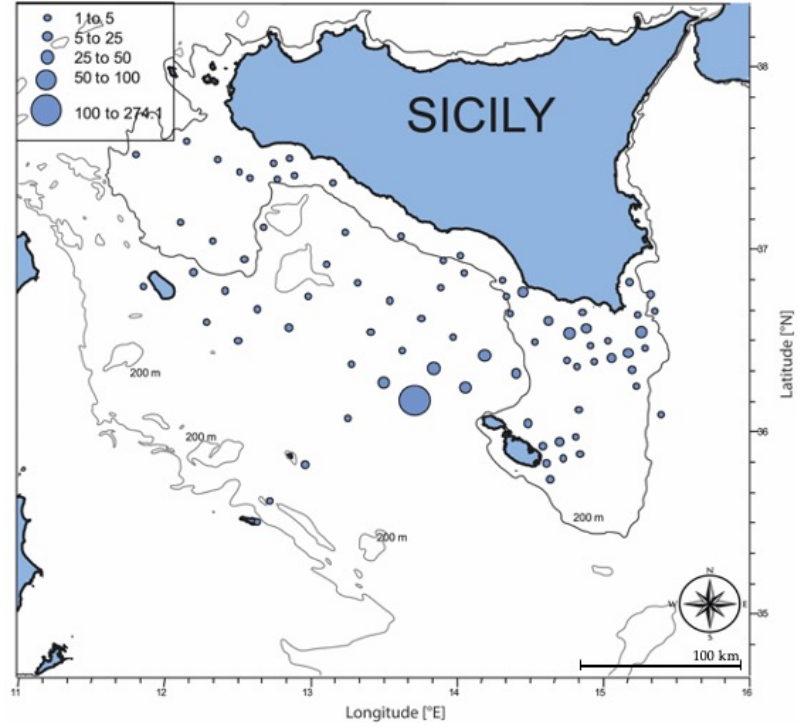
Figure 3. Abundance of anchovy larvae in the sampling stations of survey carried out in summer 2009. The size of filled circles is proportional to the number of larvae found in planktonic samples.